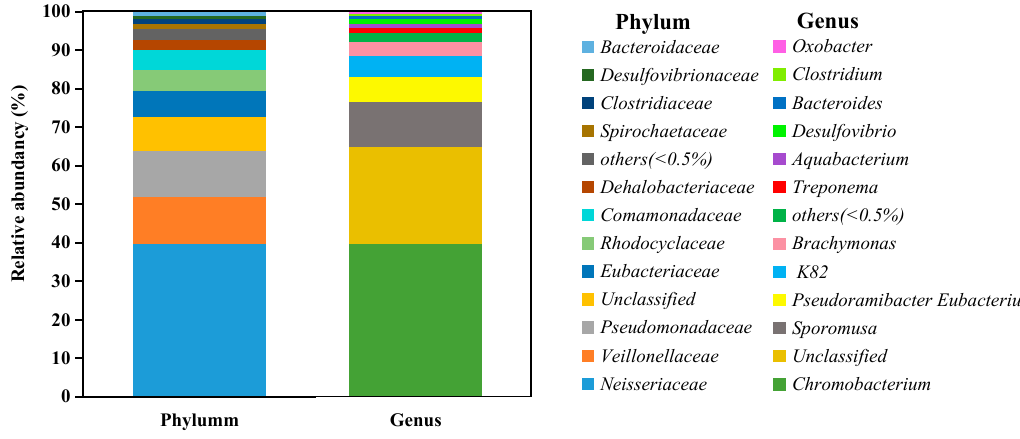
Figure 1. Composition of acclimated microbial consortium at the phylum and genus levels.